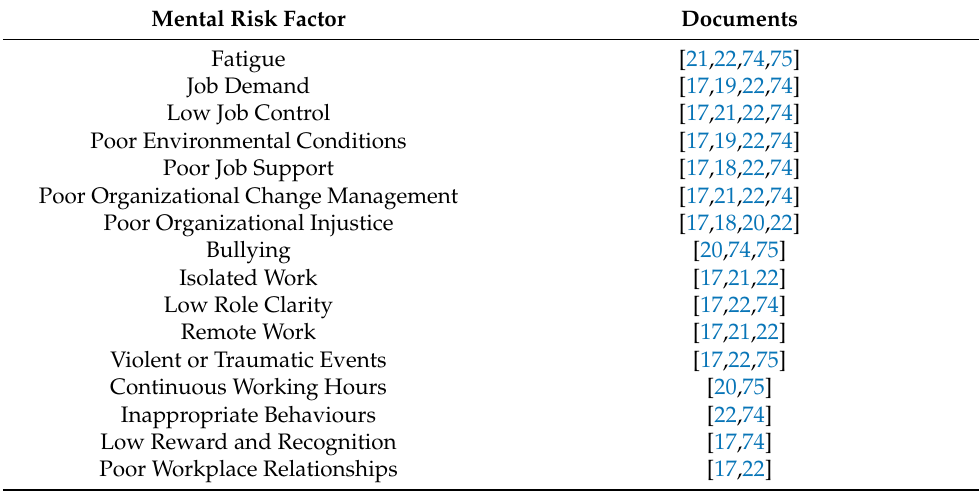
Table 4. Mental risk factors in the retrieved laws, regulations, and codes of